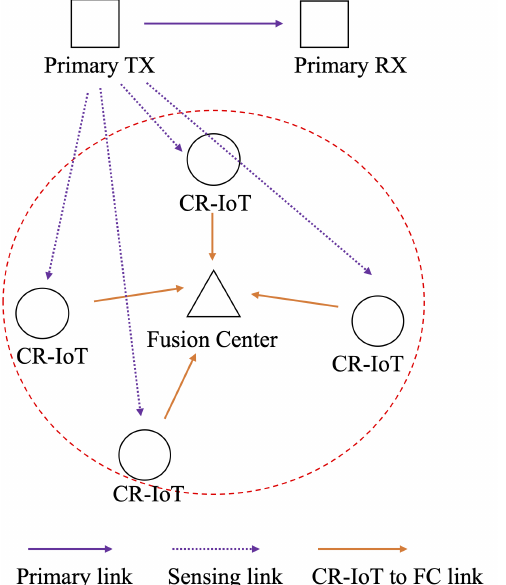
Figure 1. Proposed system model with a primary link and a cognitive radio-based Internet of Things (CR-IoT) network including a fusion center